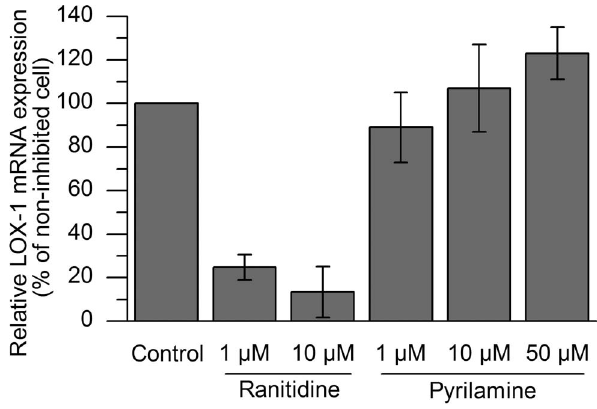
Figure 4. Effect of histamine H1 and H2 receptor antagonists on histamine-induced macrophage LOX-1 mRNA expression. Monocyte-derived macrophages were incubated in the presence of 10 m M histamine and the indicated concentrations of the histamine H1 and H2 receptor antagonists (pyrilamine and ranitidine, respectively) for 4 h and analyzed for LOX-1 mRNA expression. The results are presented as means 6 SEM (n=3 donors). All statistical comparisons were non-